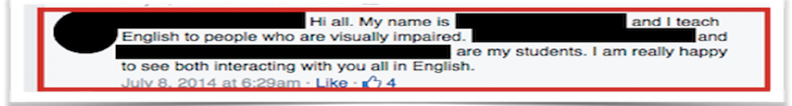
Figure 5. Professor/researcher praising students in the target language. Retrieved from [44] with